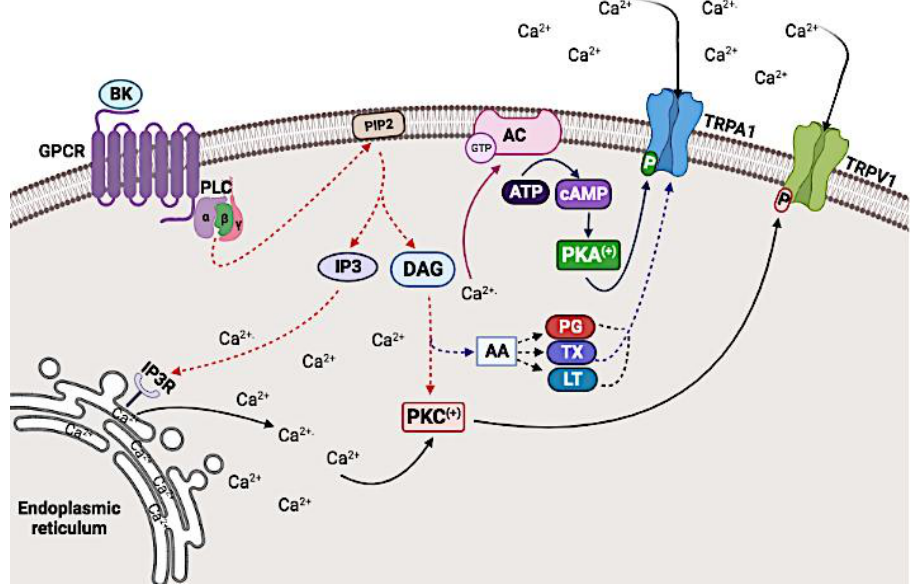
Figure 3 . Modulation of the TRPV1 and TRPA1 channels by bradykinin (BK). BK binds to its BR2 receptor, which activates the phospholipase C (PLC) pathway resulting in hydrolysis of phosphatidylinositol bisphosphate (PIP2) into inositol triphosphate (IP3) and diacylglycerol (DAG). IP3 induces the release of Ca 2+ from the endoplasmic reticulum, thus, increasing the intracellular Ca 2+ concentration. This increase activates protein kinase C (PKC), which phosphorylates TRPV1 and activates adenylate cyclase (AC) resulting in an increase in cAMP activating protein kinase A that phosphorylates TRPA1. DAG is hydrolyzed into AA, which is the precursor for the synthesis of inflammatory mediators, such as prostaglandins (PG), thromboxanes (TX), and leukotrienes (LC), that activate TRPA1. Created with BioRender.com, accessed on 28 June 2021.